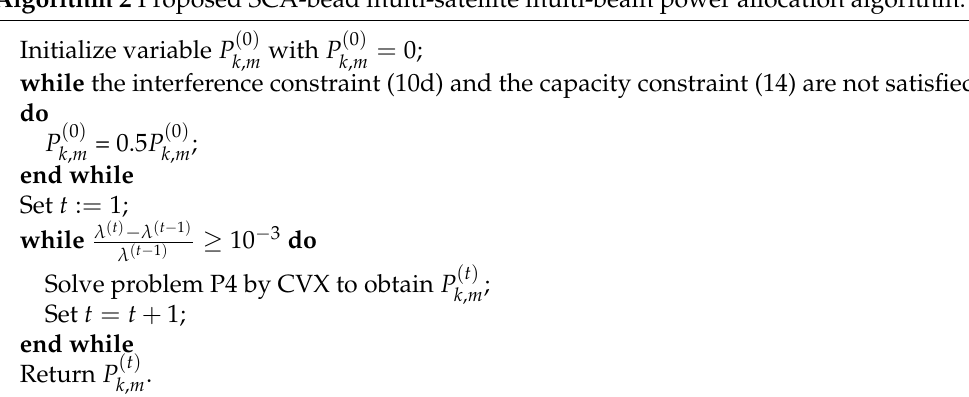
Algorithm 2 Proposed SCA-bead multi-satellite multi-beam power allocation